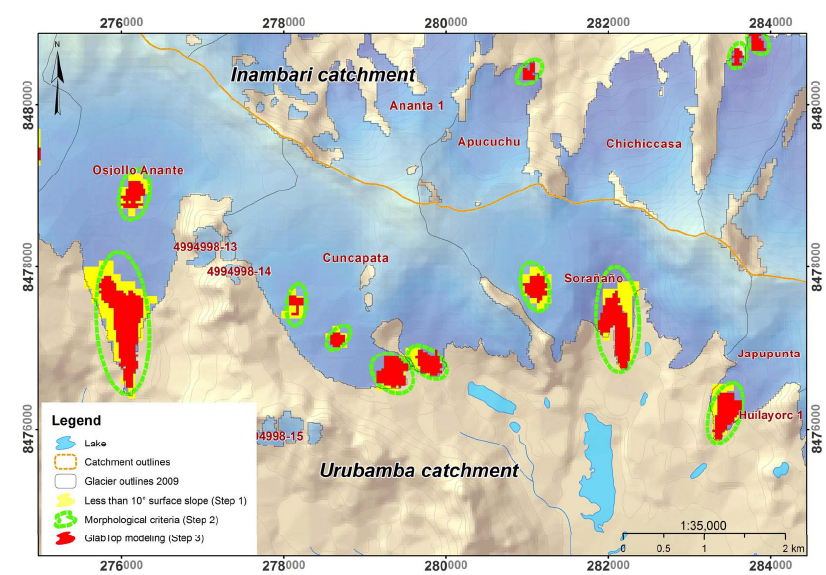
Figure 4. Comparison of results from step 1 (surface slope < 10 ◦ ) and step 2 (three morphological criteria) with step 3 (GlabTop modeling of bed topographies) for a region in the Cordillera Blanca ( top ) and one in the Cordillera Vilcanota ( bottom ). Glacier outlines are from [15] and coordinates from UTM zones 18s (Blanca) and 19s